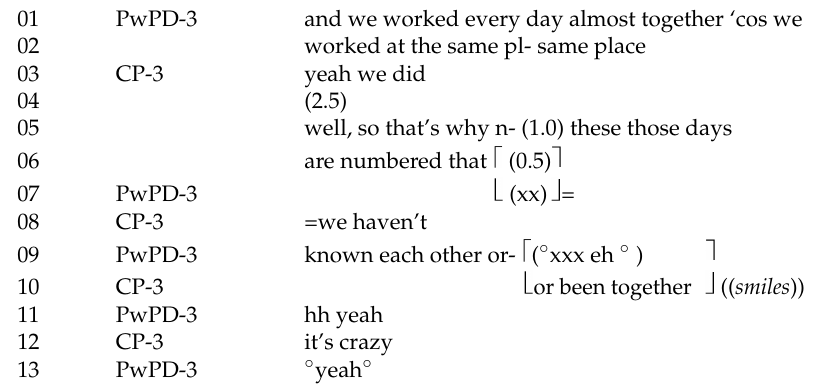
Figure 3. Word retrieval problem, quickly